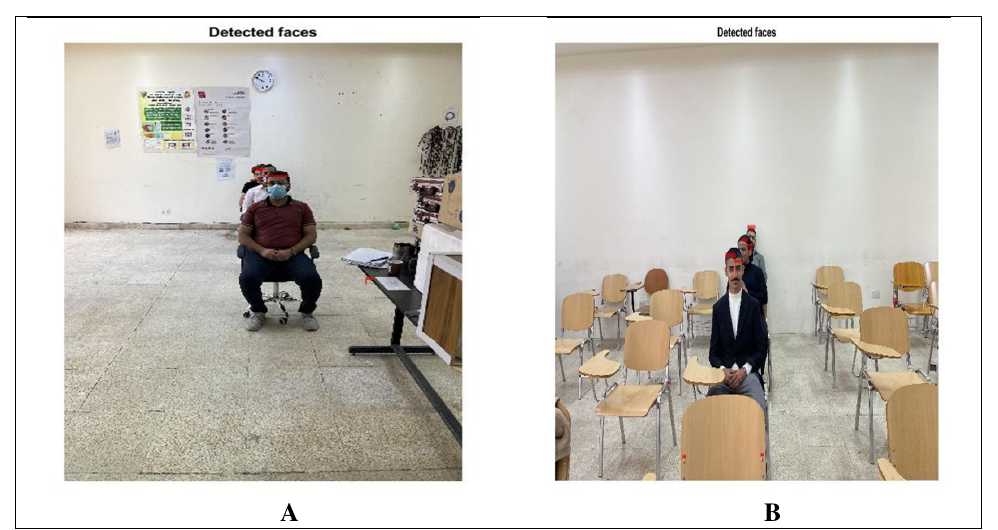
Fig. 11. Face detect when people are sitting one behind the other.